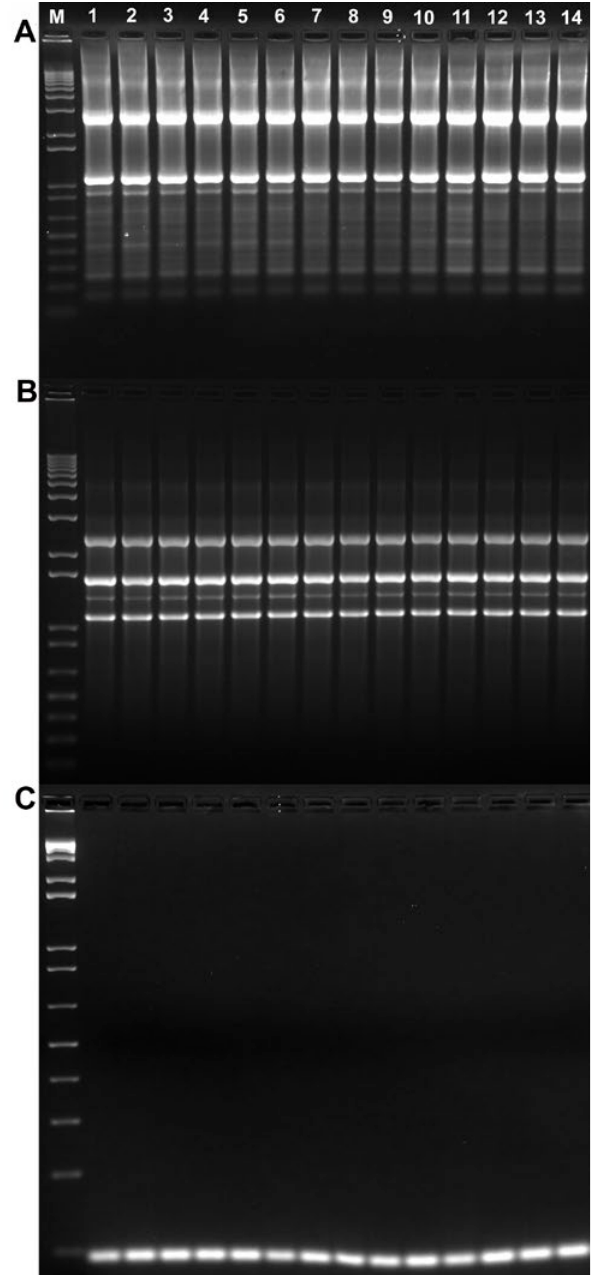
Figure 2. Gel electrophoresis of amplifications obtained by ERIC1R/ERIC2 primers (Panel A) RAPD primer OPH07 (Panel B) and VNTR primer SSR21 (Panel C) for fourteen Xylella fastidiosa isolates used in this study. Lane M: 1 Kb- plus ladder marker (Life Technologies); Lanes 1-14: L2stA1, L2stA2, L6A1, L6A2, L3stA2, Salento-1, Salento-2, CG3A1, S2A1, CM4A1, CM4A2, Cast1A, Cast2AT,